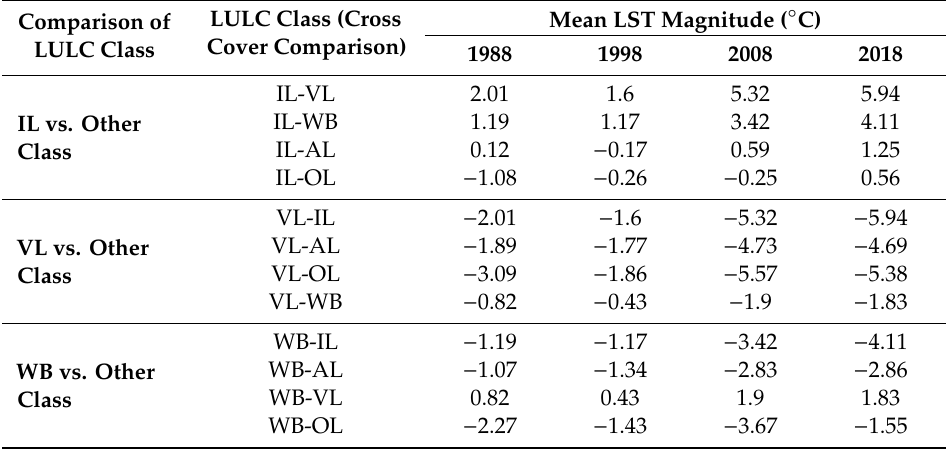
Table A4. Comparisons of mean LST between Land Use / Land Cover classes from 1988 to 2018. Comparison of LULC